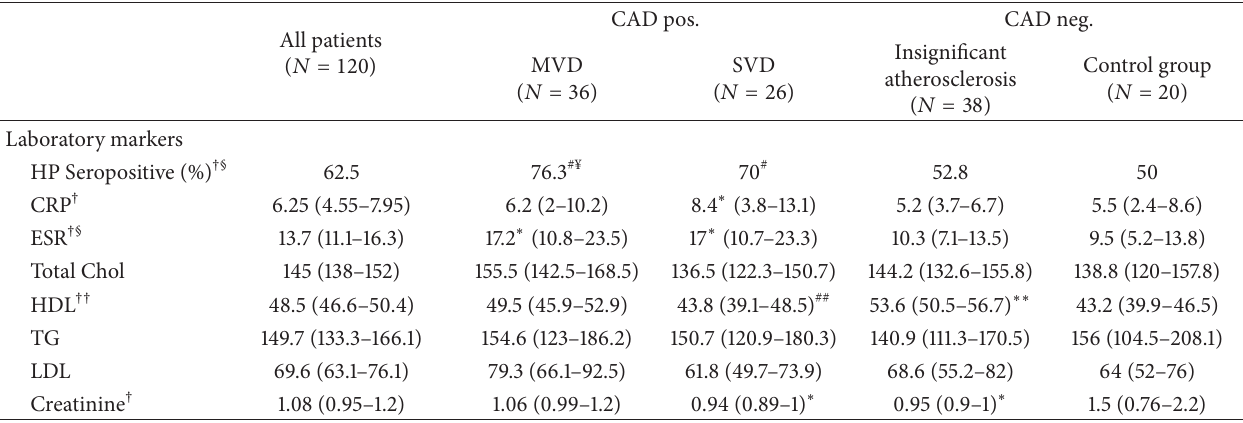
Table 2: Laboratory markers in groups of